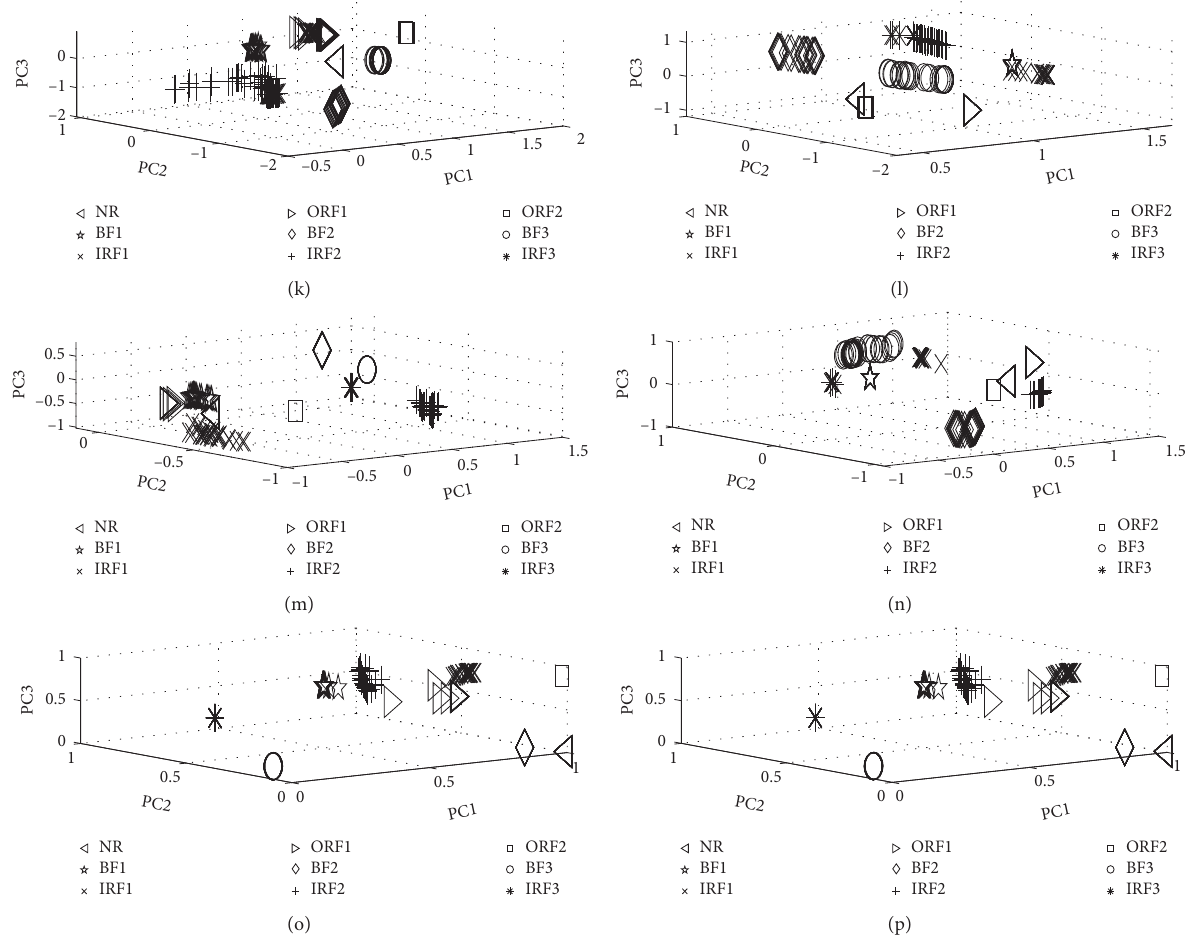
Figure 8: The 3-dimensional results of different datasets for the training dataset through eight hidden layers by using an SDAE with PCA dimension reduction; 1–8 denote the hidden layer number. (a) SDAE-A-512-training data. (b) SDAE-B-512-training data. (c) SDAE-A-256- training data. (d) SDAE-B-256-training data. (e) SDAE-A-128-training data. (f) SDAE-B-128-training data. (g) SDAE-A-64-training data. (h) SDAE-B-64-training data. (i) SDAE-A-32-training data. (j) SDAE-B-32-training data. (k) SDAE-A-16-training data. (l) SDAE-B-16- training data. (m) SDAE-A-8-training data. (n) SDAE-B-8-training data. (o) SDAE-A-3-training data. (p) SDAE-B-3-training